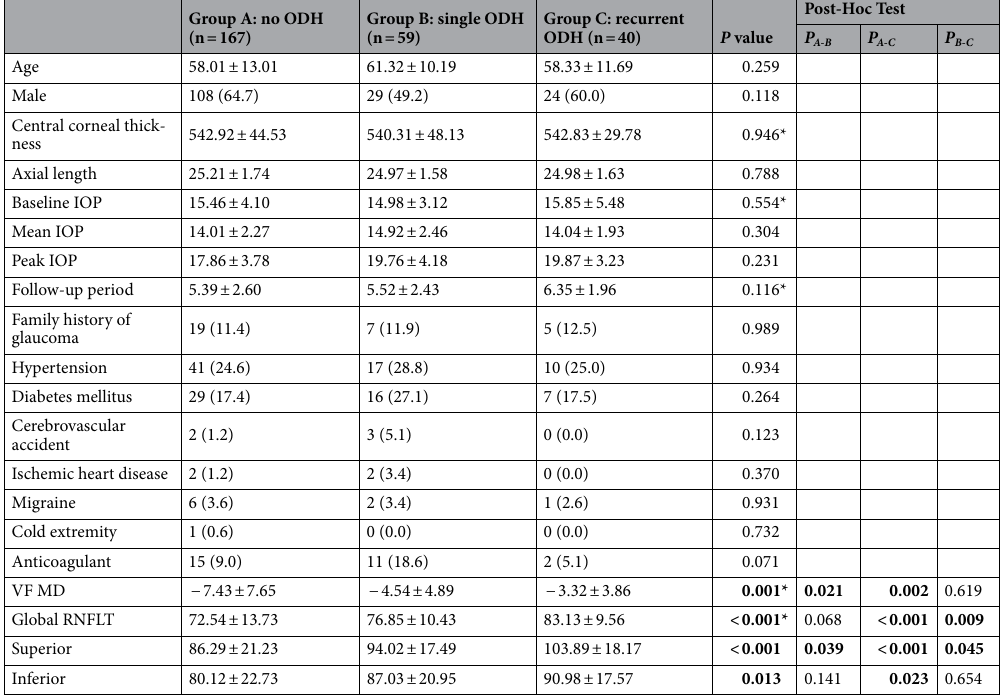
Table 1. Baseline characteristics of patients with primary open-angle glaucoma with and without optic disc hemorrhage (ODH). IOP intraocular pressure, VF visual field, MD mean deviation, RNFLT retinal nerve fiber layer thickness. Comparison was performed using one-way analysis of variance with post-hoc tests (Tukey or *Dunnett T3). Statistically significant values are in